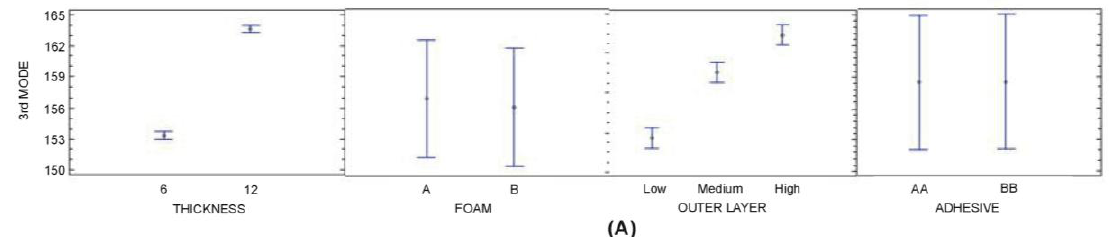
Figure 12. ( a ) 3rd Mode (95% confidence interval ( b ) 3rd Mode: A×B, A×C and B×C interactions (95% confidence